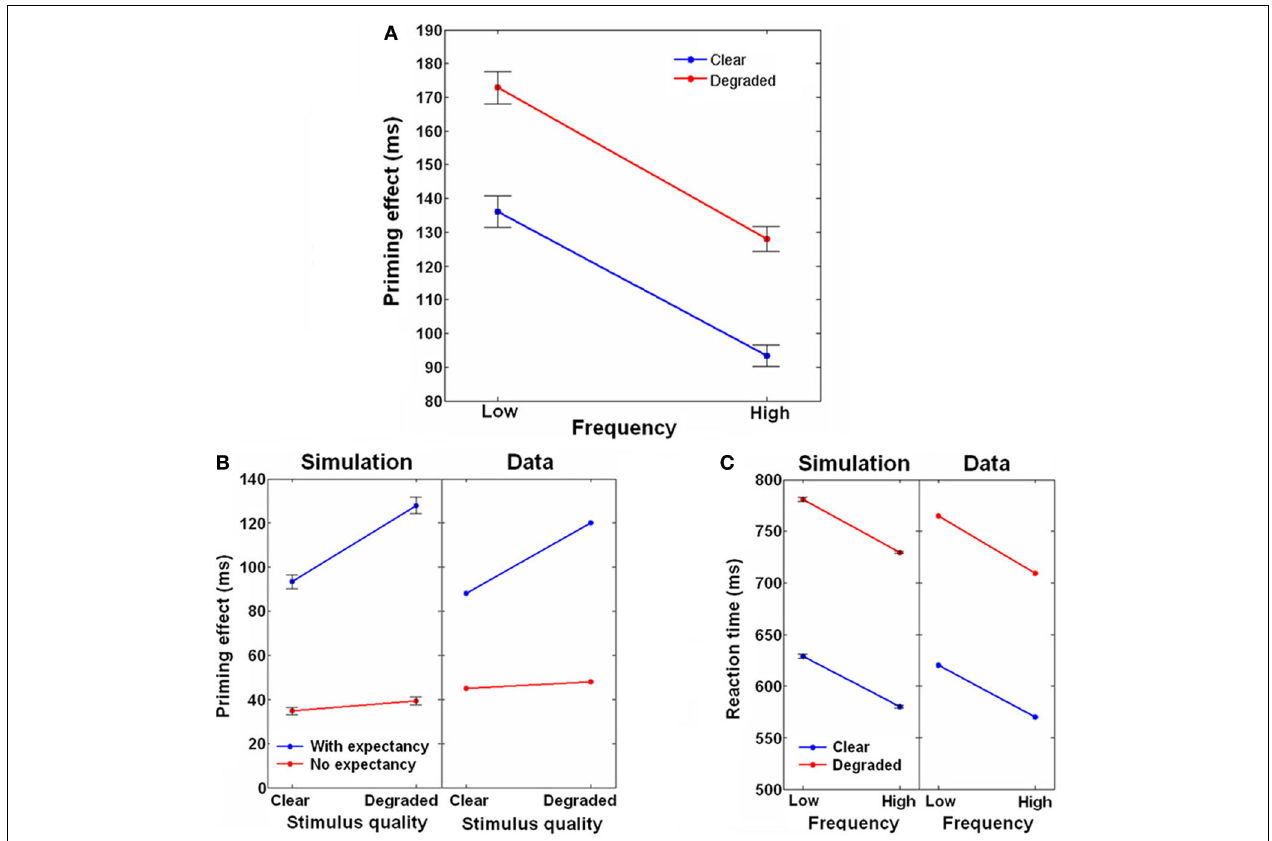
FIGURE 7 | Joint effects of frequency, stimulus-quality and context. (A) Priming effect as a function of targets’ stimulus-quality (Clear, Degraded) and frequency (Low, High), with expectancy active. (B) Effects of stimulus-quality on priming with and without expectancy. Simulation results are compared to human data taken from Stolz and Neely (1995). Data of the